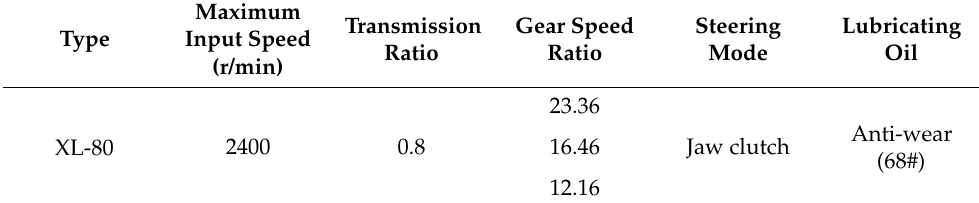
Table 6. Main parameters of the XL-80 driving rear